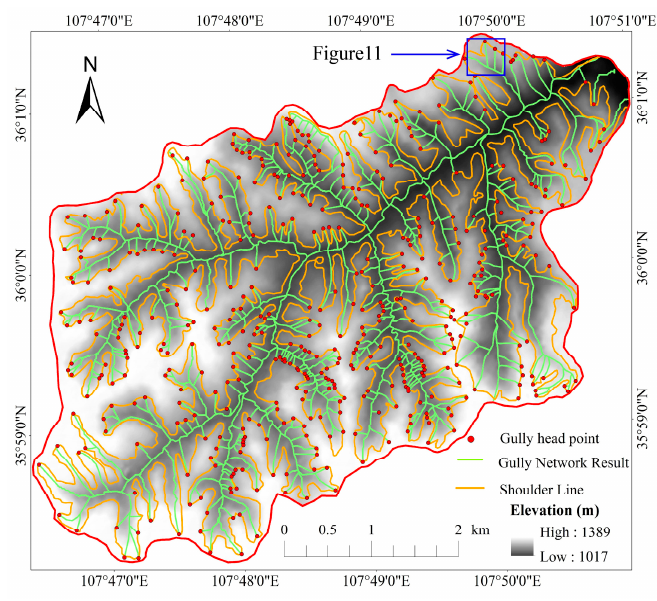
Figure 10. The gully system map.